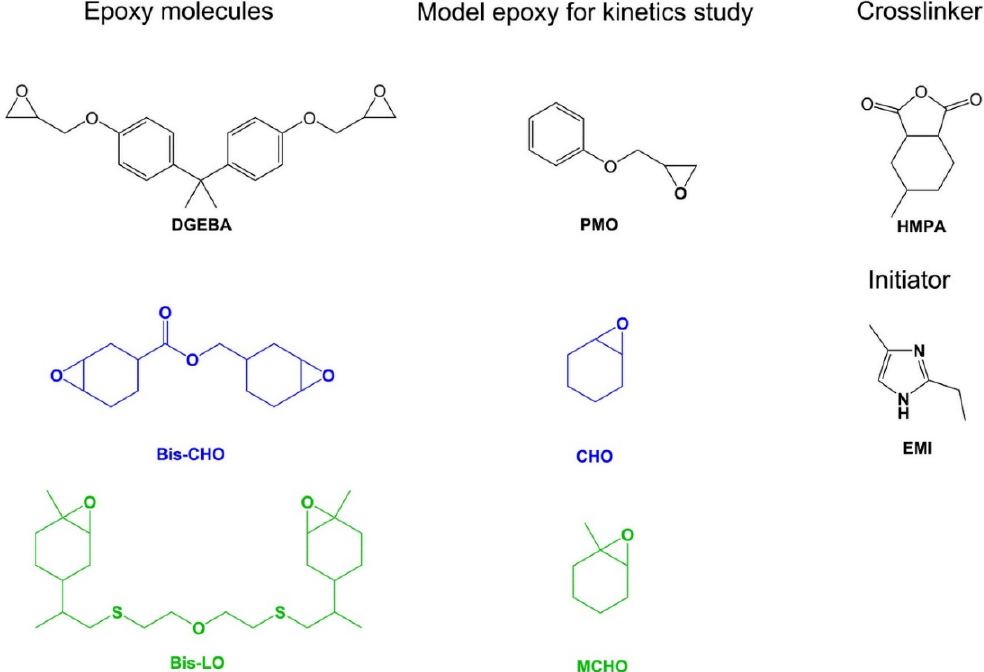
Figure 1. Chemical structure and abbreviations of the model molecules, diepoxides, curing agent and initiator catalyst.